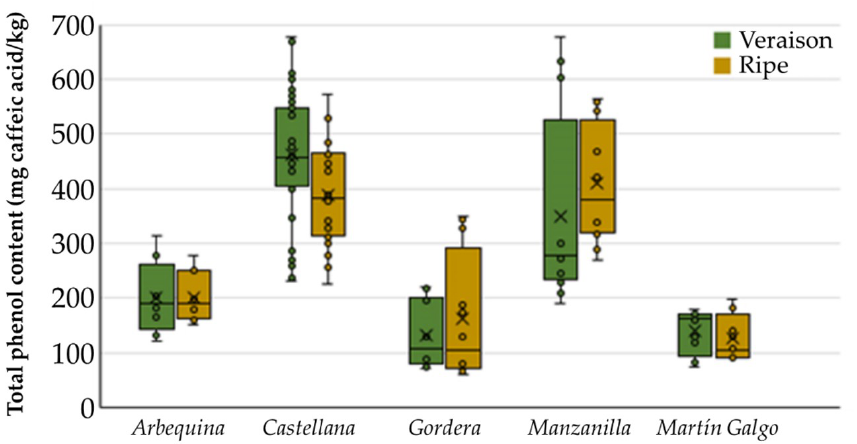
Figure 1. Total phenol content (mg caffeic acid/kg) for the virgin olive oils produced with the varieties of olives cultivated in the Aceite de la Alcarria PDO (veraison and ripe). The whisker ends show the maximum and minimum values, while the X represents the mean values of the oils elaborated across the four consecutive olive crop seasons under study.